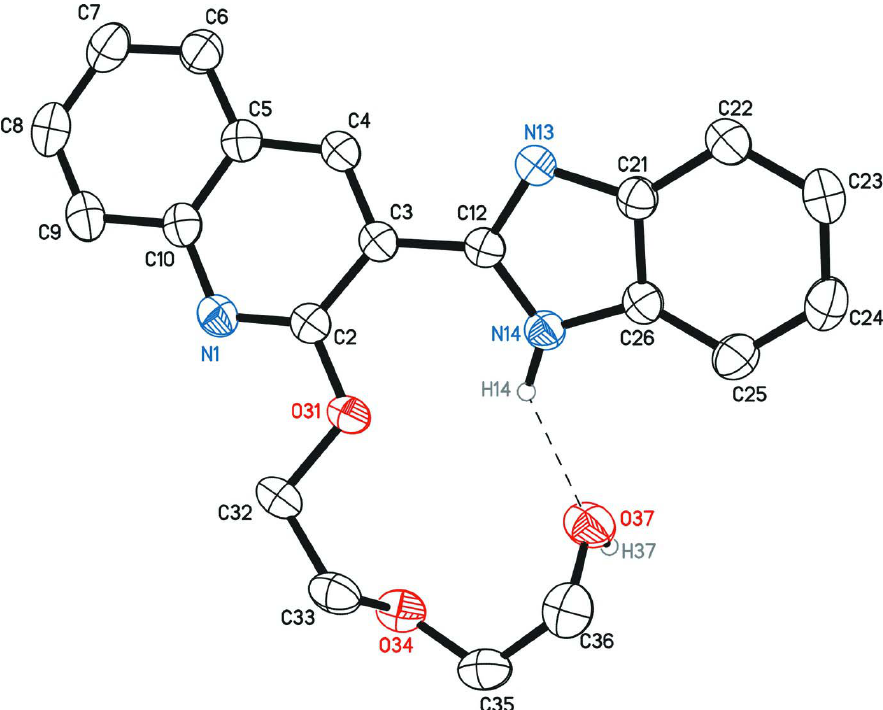
Thermal ellipsoid representation of the title compound with the intramolecular hydrogen bond indicated as dashed line. Displacement ellipsoids were plotted at 50% probability